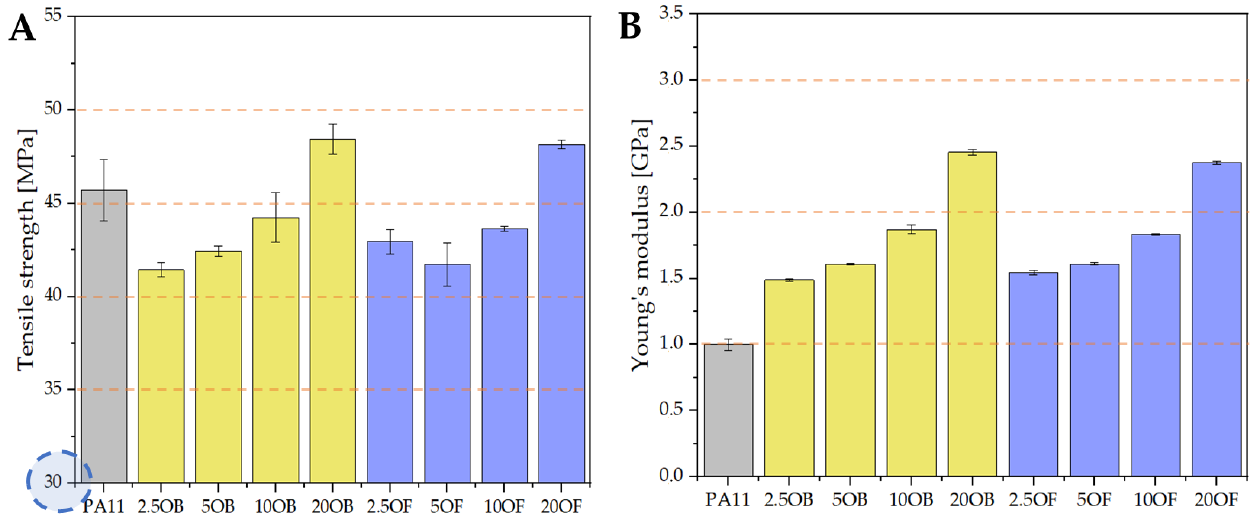
Figure 9. The results of the static tensile test are as follows: ( A ) the tensile strength and ( B ) the Young’s modulus of the biocomposites conditioned at room temperature (RT).